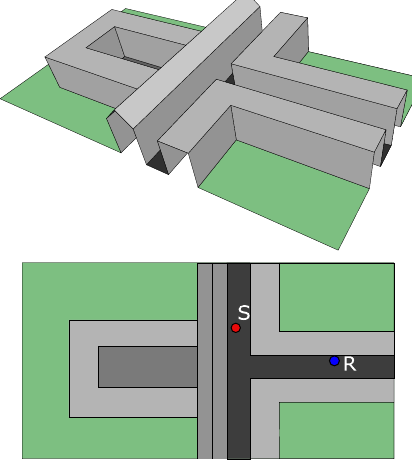
Figure 8. An urban environment consisting of buildings at a T junction with asymmetric locations of a source and a